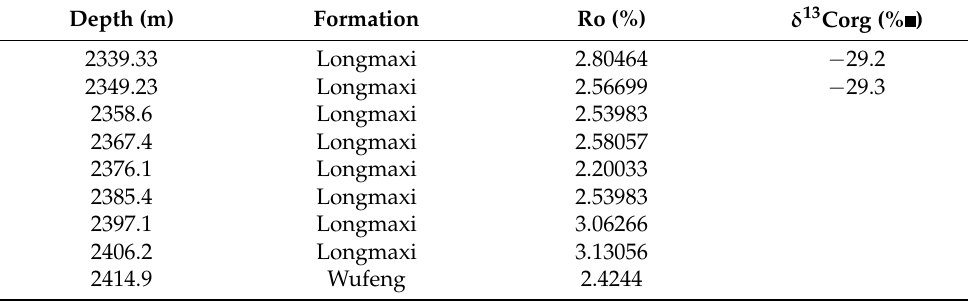
Table 1. Organic geochemical data of Wufeng-Longmaxi Formation in Well A.